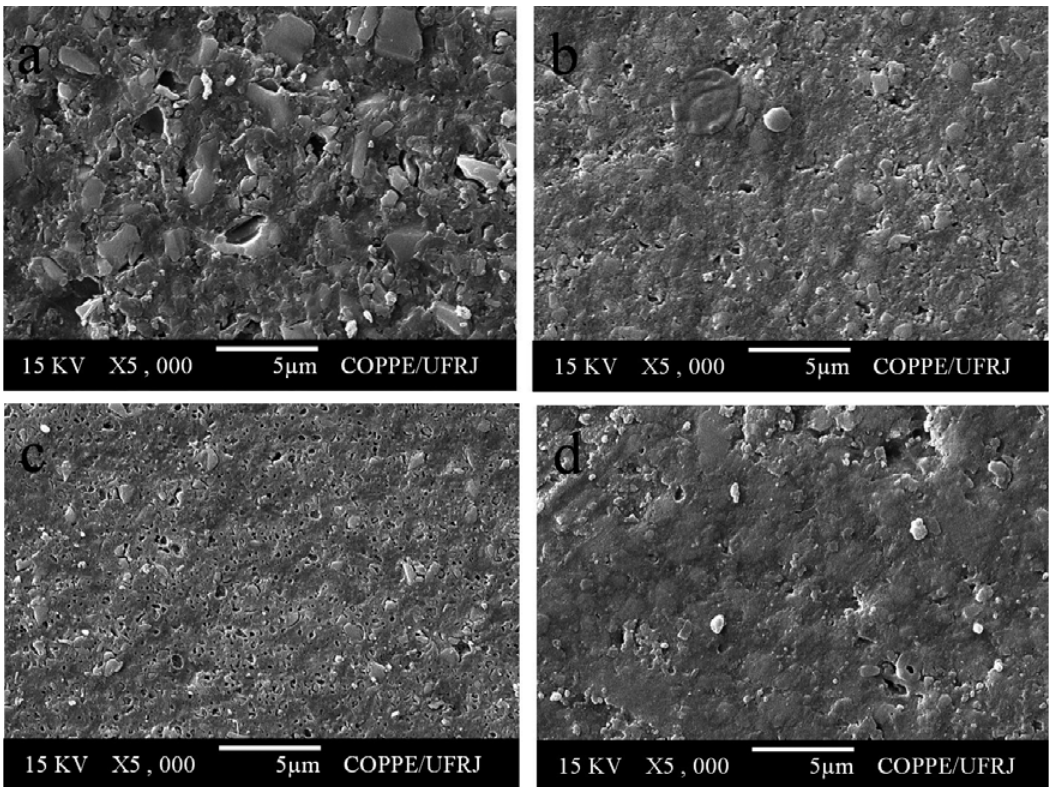
FIGURE 6- Representative SEM photomicrographs of resin-based composites after pH-cycling and immersion in Dimetapp ® . (a) TPH, (b) Concept, (c) Opallis and (d)